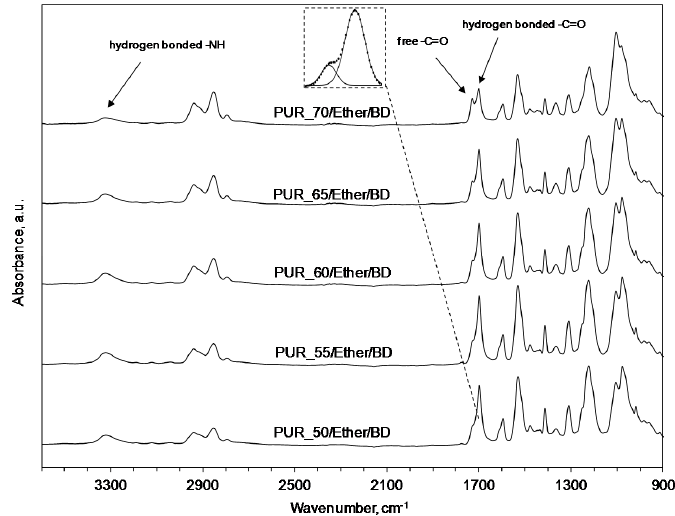
Figure 5. FT-IR spectra of PUR with different content levels of polyether soft segments.